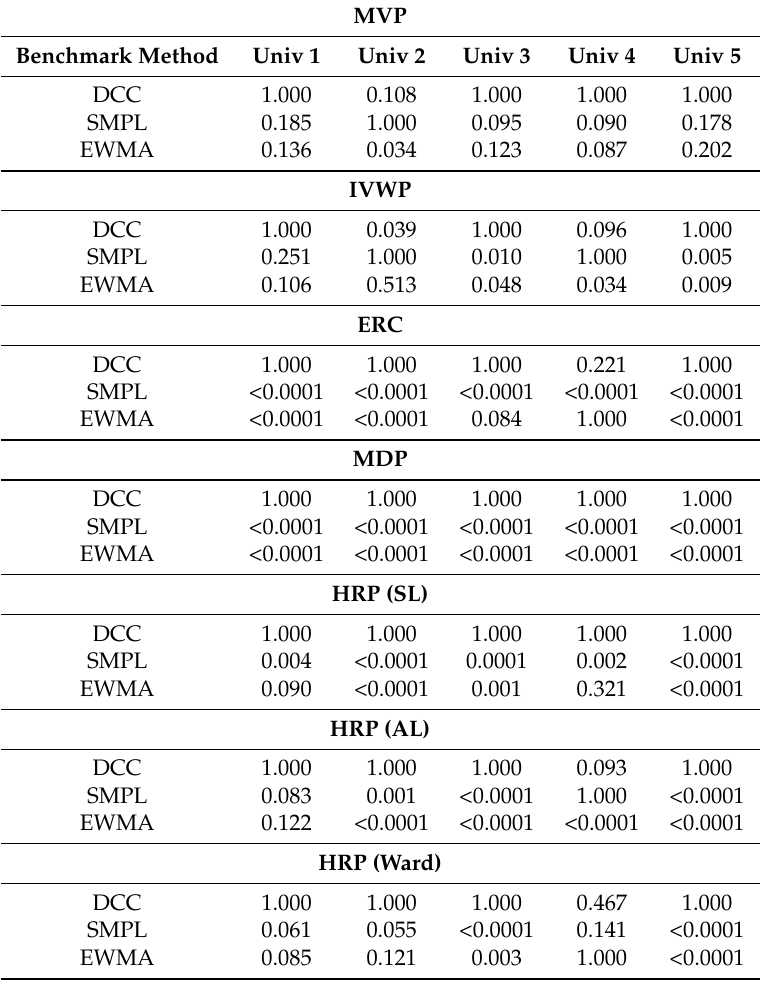
Table 3. p -values from the SPA test when DCC, SMPL, and EWMA are chosen as the benchmark model respectively for the different portfolio allocation techniques. The corresponding loss functions considered for each portfolio allocation technique are provided in Table